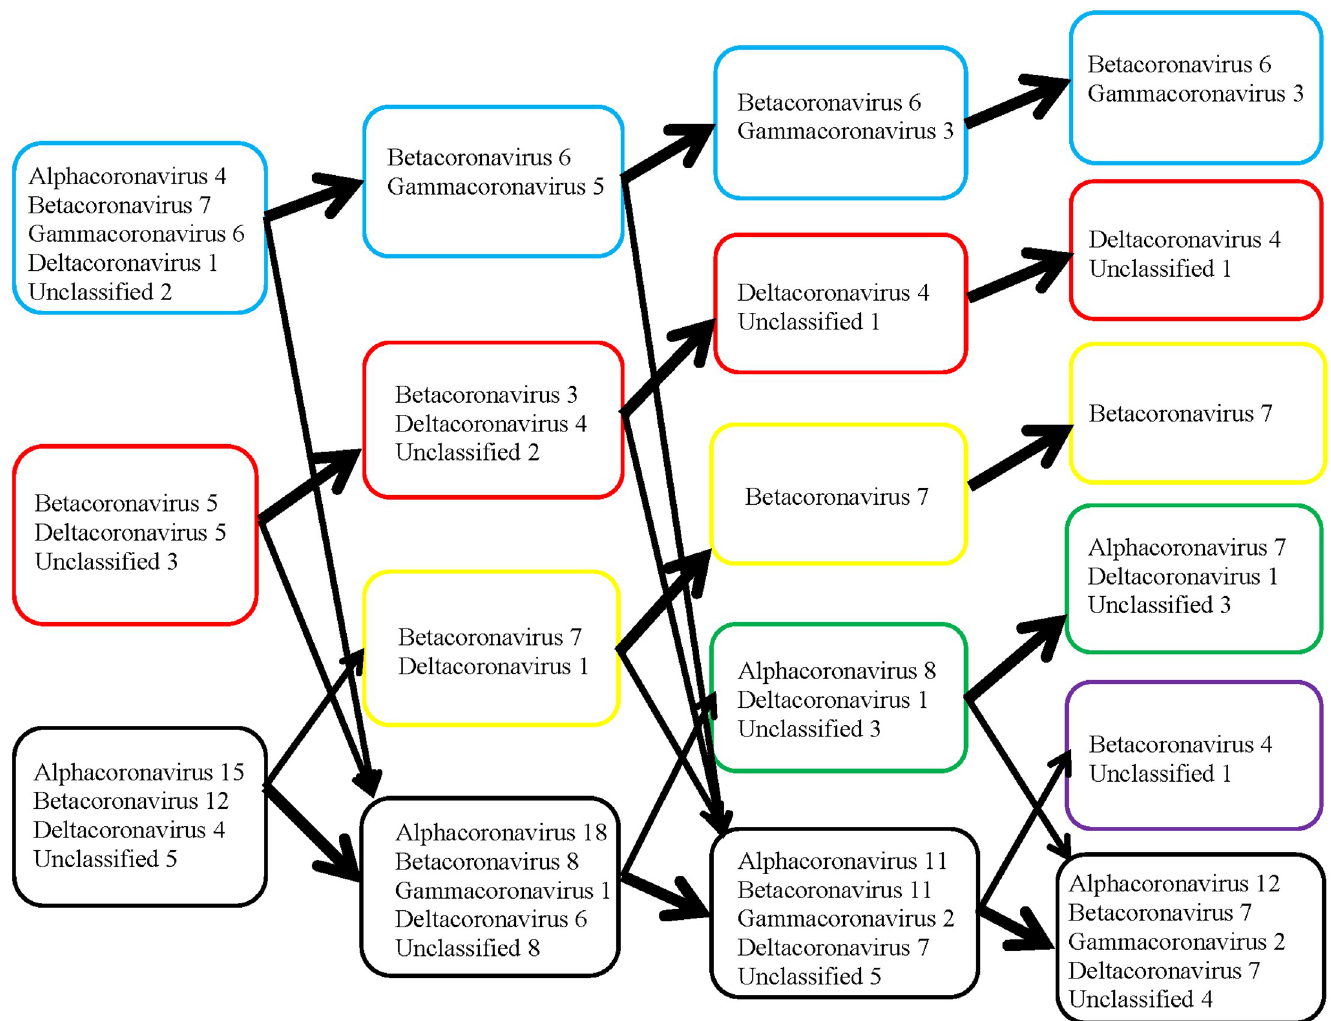
Fig 2. Results of step-by-step classification of 69 coronavirus genomes belonging to different genera by K -means (from 2 to 5 classes). Boxes in a blue frame represents the 1st class, red—2 nd class, yellow—3 rd , green—4 th , violet—5 th , black—unclassified volatile genomes, the position of which was unstable between classes.